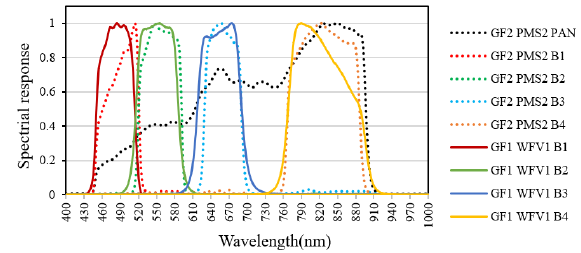
Figure 1 . Spectral response function curves of GF-1 WFV and GF-2 PMS.